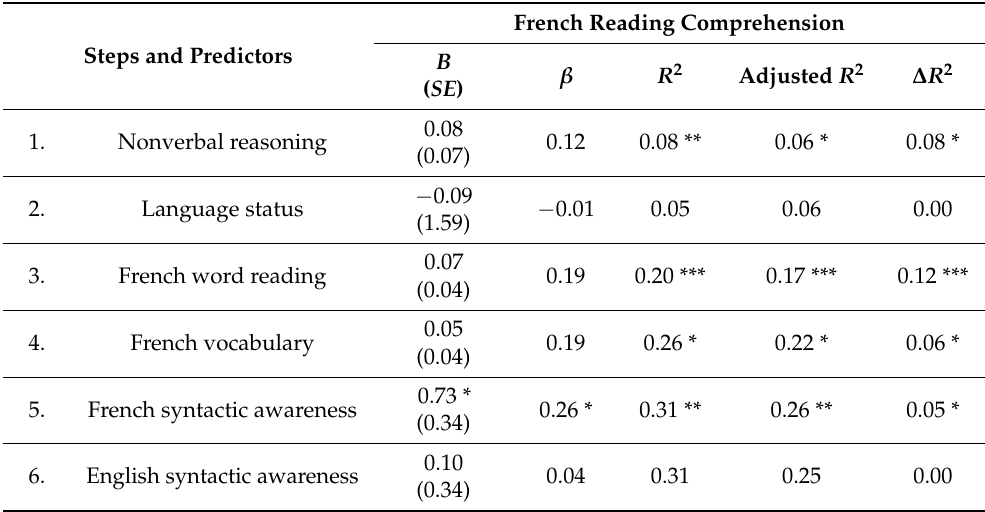
Table 3. Hierarchical Linear Regression Predicting Grade 3 French Reading Comprehension.